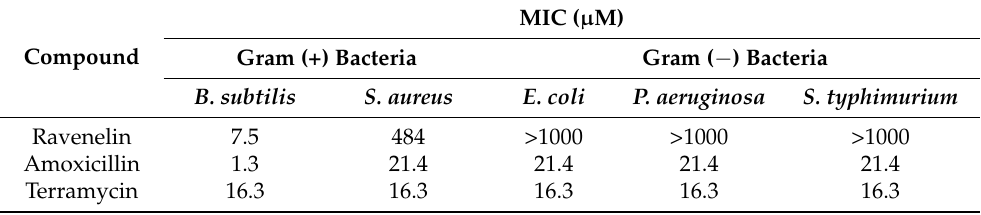
Table 1. Minimum inhibitory concentration (MIC) of ravenelin for Gram-negative and Gram- positive bacteria.